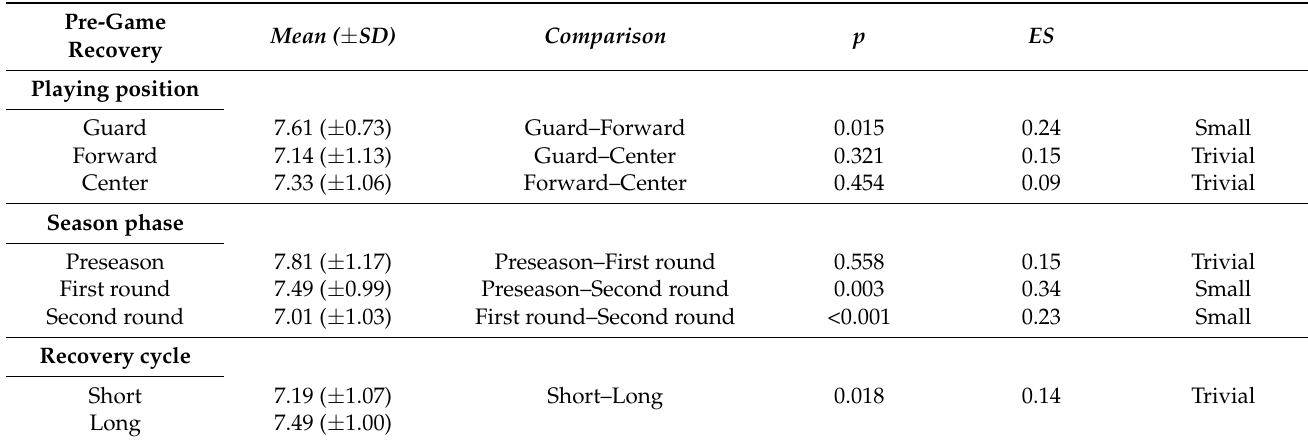
Table 8. Pairwise comparison for pre-game